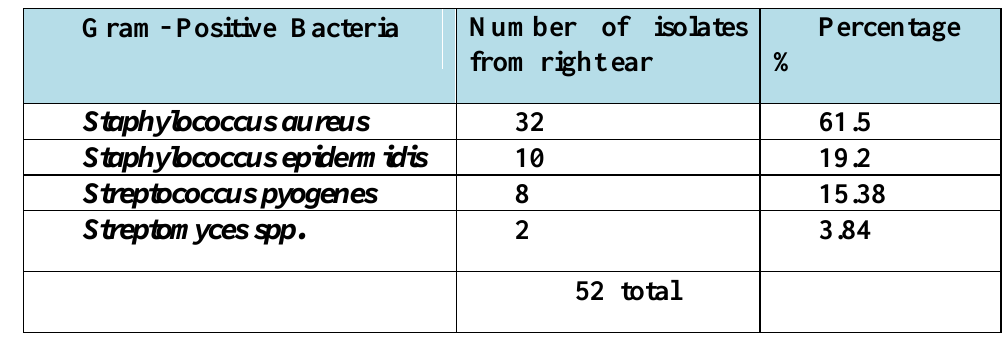
Table 4: Numbers of gram positive bacteria from infected left ear in sheep Gram- Positive Bacteria Number of isolates Percentage % from left ear